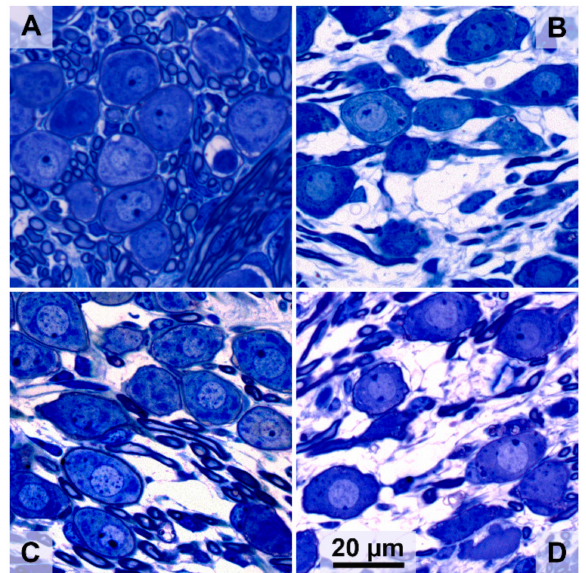
Figure 5. Representative examples of SGCs in Rosenthal’s canal at cochlear location B1 from the treated right ears. ( A ) Normal-hearing animal; ( B ) untreated 6 weeks deaf (6WD) animal; ( C ) BDNF-treated animal; ( D ) 7,8,3 (cid:48) -trihydroxyflavone (THF)-treated